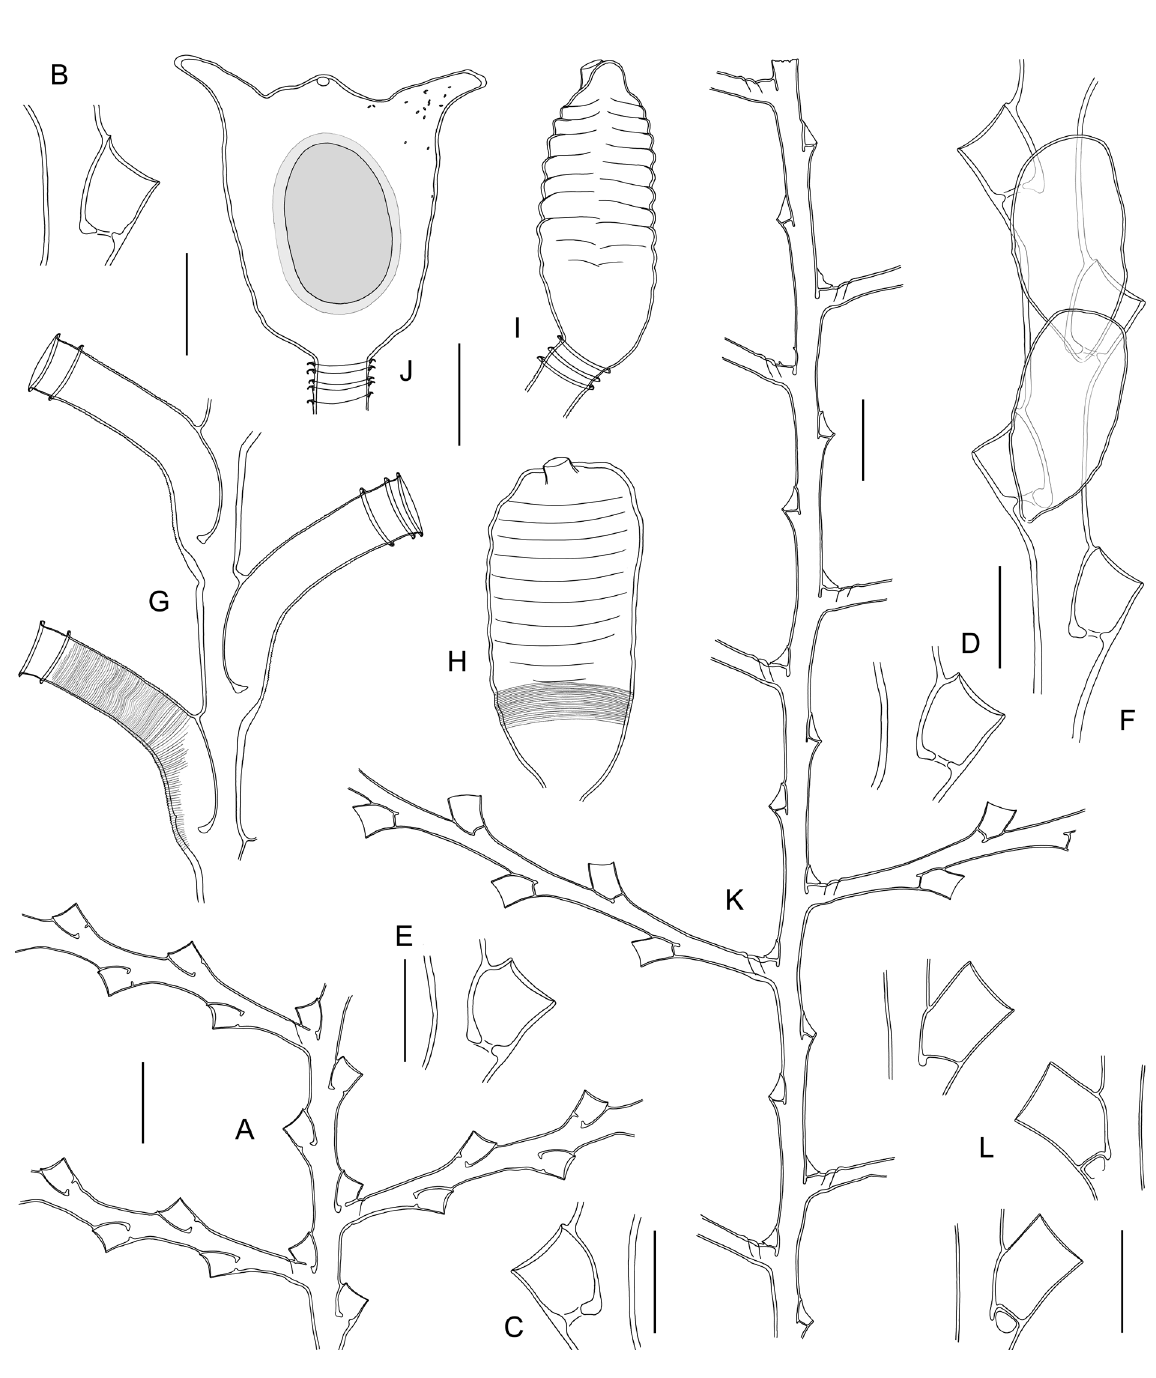
Fig. 7. A–F . Hincksella immersa Galea, sp. nov., portion of stem with three cladia (A), four hydrothecae (B–E) showing varied degree of immersion, portion of cladium with gonothecae (F), all from sample MNHN-IK-2015-390. — G–J . ? Hincksella neocaledonica Galea, 2015, portion of stem with three hydrothecae (G), immature gonotheca in frontal (H) and lateral (I) views, all from sample MNHN- IK-2015-384; fully-formed gonotheca (J) from sample MNHN-IK-2015-385. — K–L . Hincksella sibogae Billard, 1918, portion of colony showing branching pattern (K), three hydrothecae (L), all from sample MNHN-IK-2015-391. Scale bars: A, K = 1 mm; B–J, L =